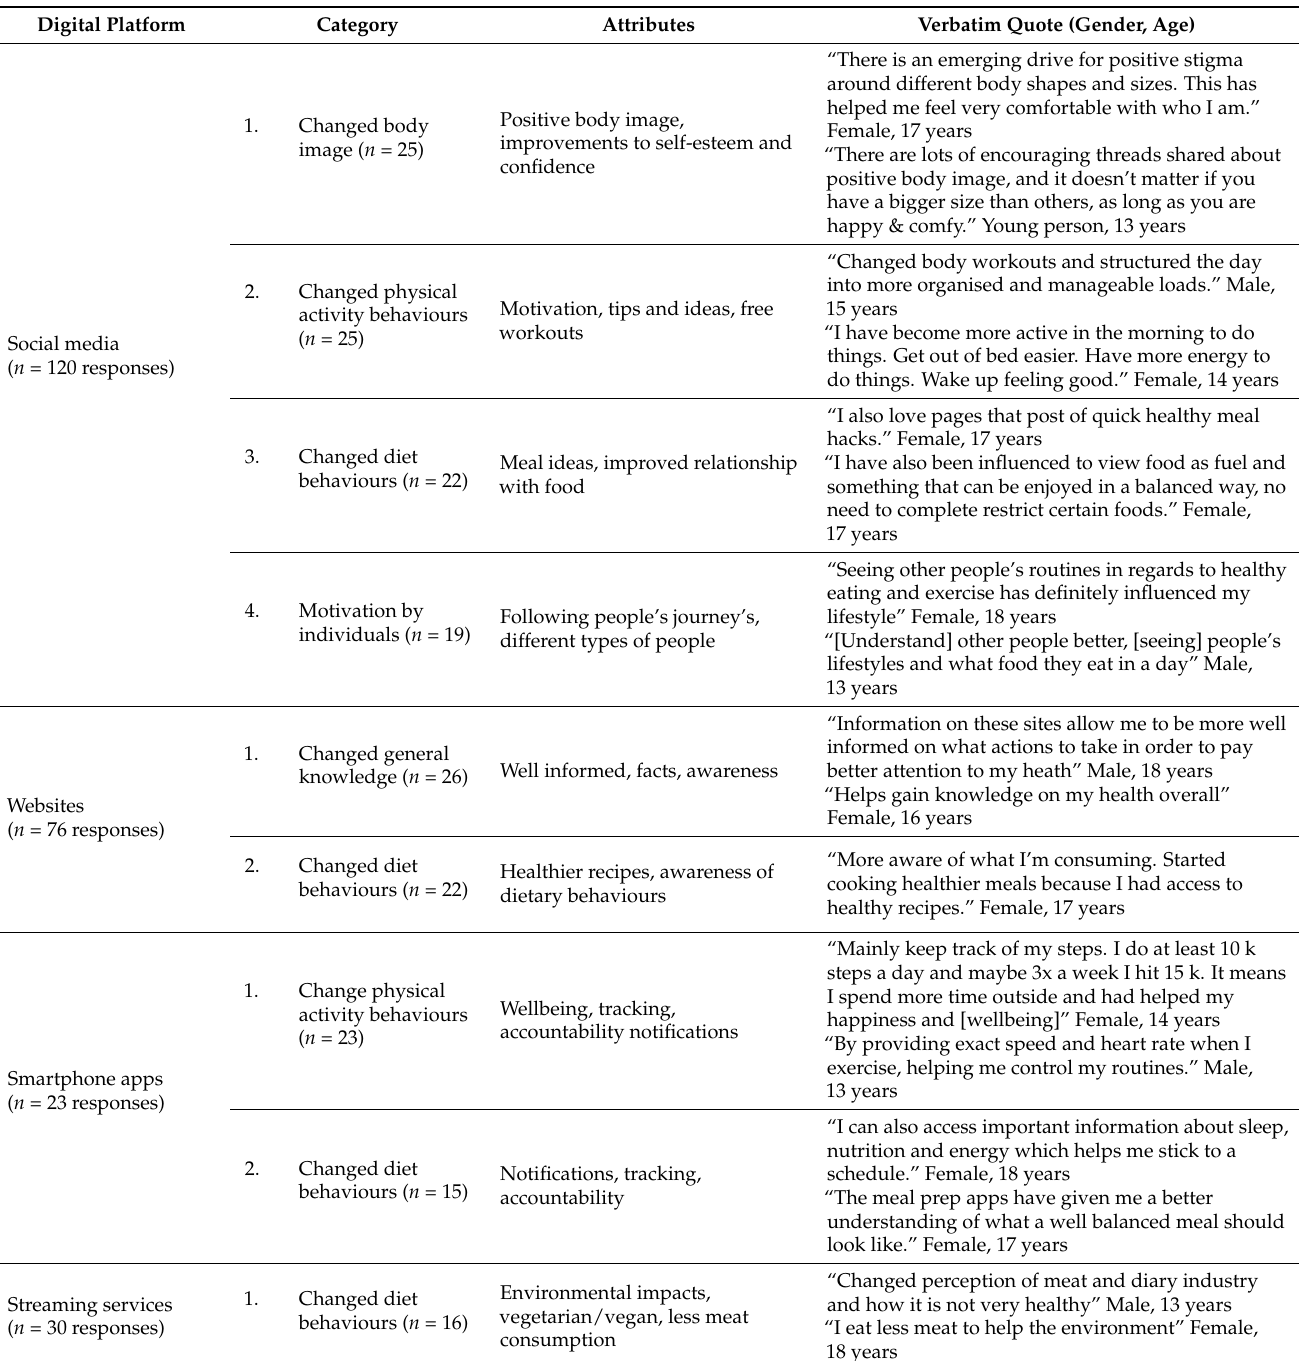
Table 2. Components, categories and attributes from the open-ended questions about helpfulness of digital platforms for behaviour